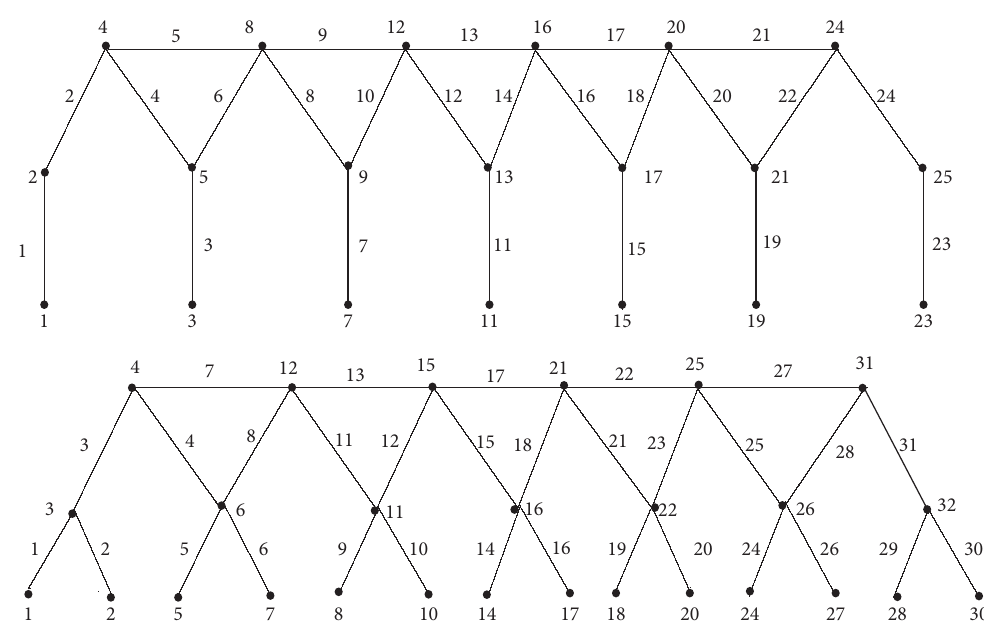
Figure 6: A classical mean labeling of L ([ P